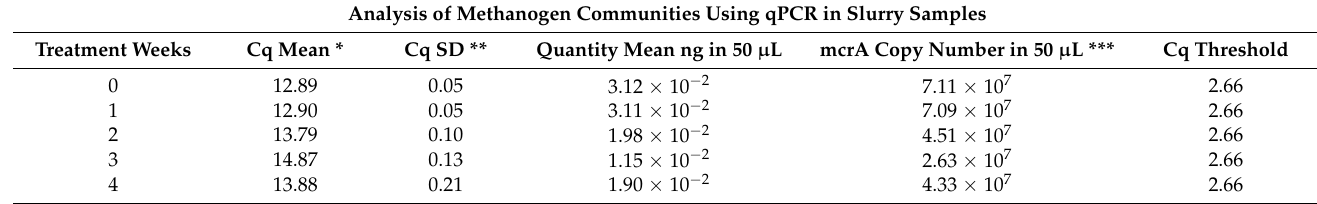
Table 3. Results of the detection and quantification of the mcrA gene qPCR. Analysis of Methanogen Communities Using qPCR in Slurry Samples